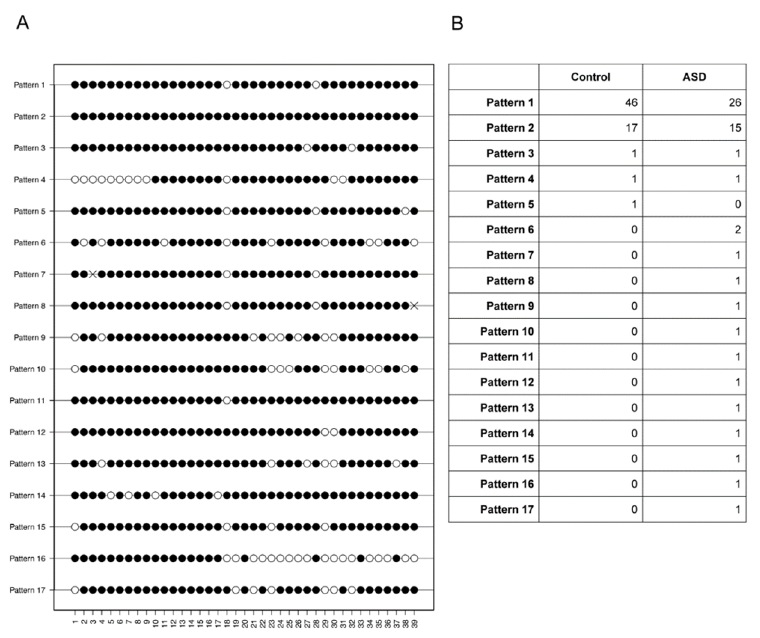
Figure 3. DNA methylation pattern diversity in the GAD1 region of interest in cerebral organoids. ( A ) Distinct patterns of DNA methylation signatures in the two >50% methylation groups. Filled dots, methylated cytosines; empty dots, unmethylated cytosines; × , cytosine-to-adenine mutation. ( B ) The number of clones within the ASD and control groups displaying each DNA methylation pattern.